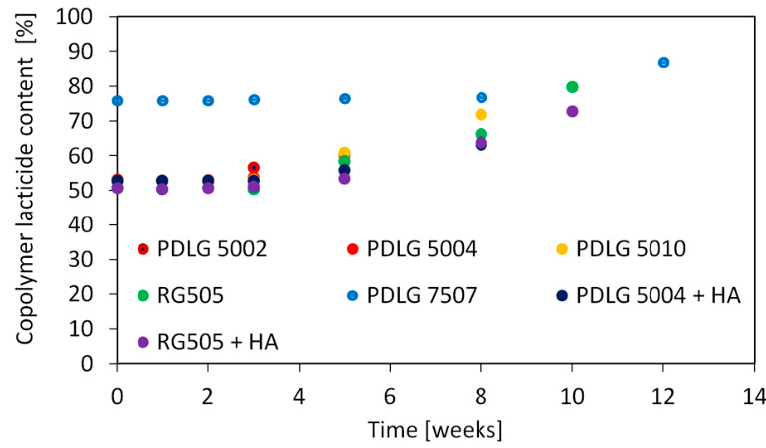
Figure 4. Lactide units content in the copolymer as a function of degradation time. Values are expressed as the arithmetic average of three independent measurements ± standard deviation.